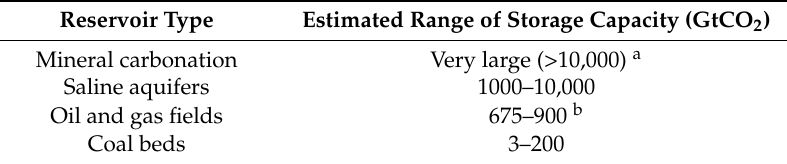
Table 1. Storage capacities for several geological storage options [11].